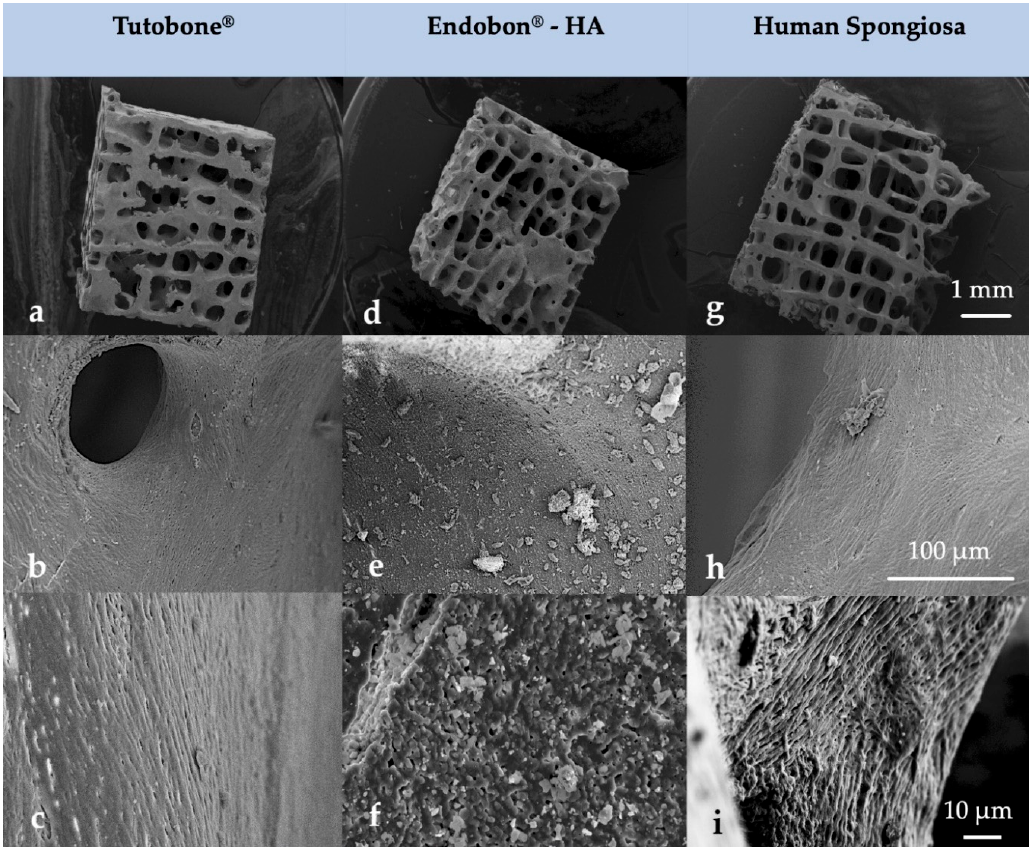
Figure 4. Surface morphology of the tested block bone graft materials ( a – c ) Tutobone ® , ( d – f ) Endobon ® - HA and ( g – i ) Human spongiosa in a magnification of ×25 (top row—( a , d , g )), ×1000 (middle row— ( b , e , h )) and ×3000 (bottom row—( c , f , i )) using scanning electron microscopy (SEM) analysis. The bar represents 1 mm, 100 µm and 10 µm, respectively.